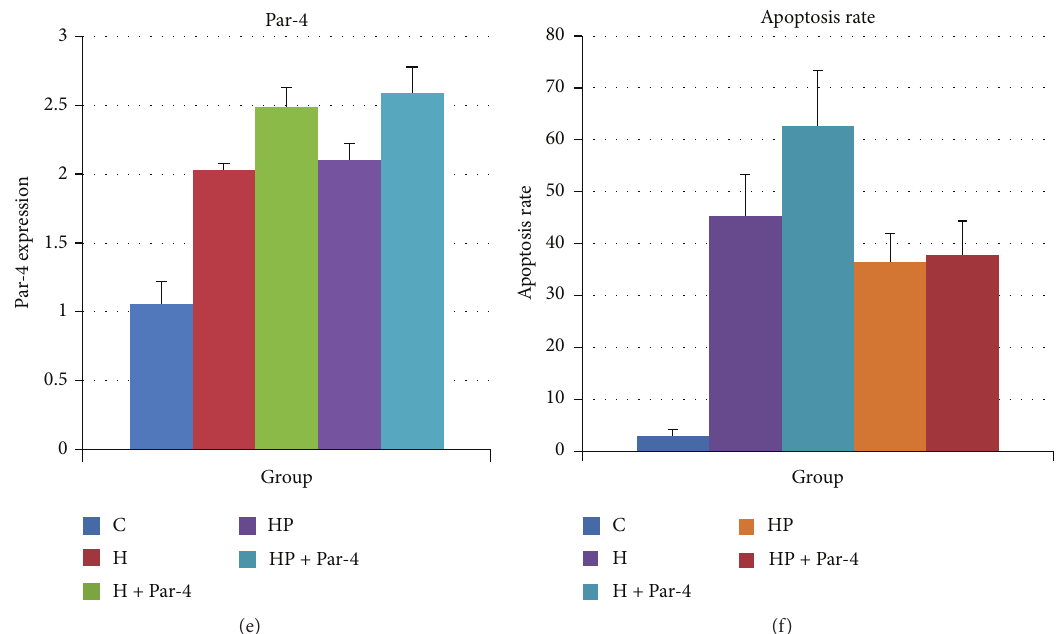
Figure 6: Inhibition of NF- 𝜅 B reduced apoptosis, which was induced by overexpression of Par-4 in high glucose/palmitate intervention NIT-1 cells.